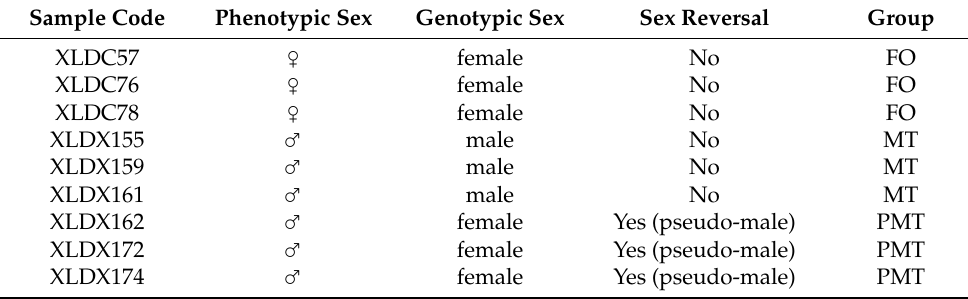
Table 2. Quality assessment of the sequencing data.